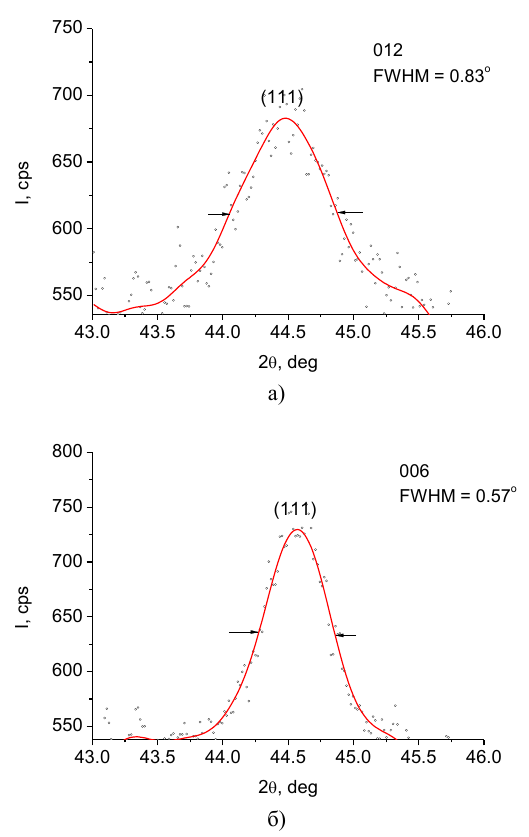
Fig. 6. The diffraction peak of permalloy film for the substrate temperature: a) 270 °С; b) 390 °С .